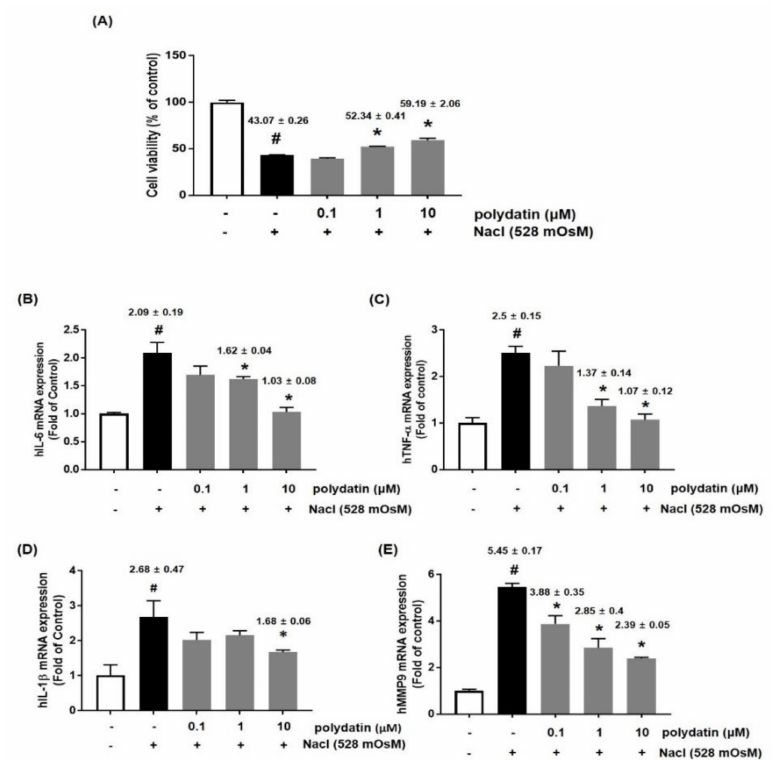
Figure 5. E ff ects of polydatin on hyperosmolar stress-induced inflammation in human conjunctival cells (HCCs). ( A ) HCCs were co-treated with polydatin (0.1–10 µ M) and hyperosmotic media for 24 h. To investigate cell viability, CCK-8 assay was performed. The mRNA levels of IL-6 ( B ), TNF- α ( C ), IL-1 β ( D ), and MMP9 ( E ) were assessed by real-time PCR assay. GAPDH was considered an internal control. Data are the mean ± SEM of three independent experiments for all groups. # p < 0.05, significantly di ff erent from the untreated group, * p < 0.05, significantly di ff erent from the hyperosmotic-treated